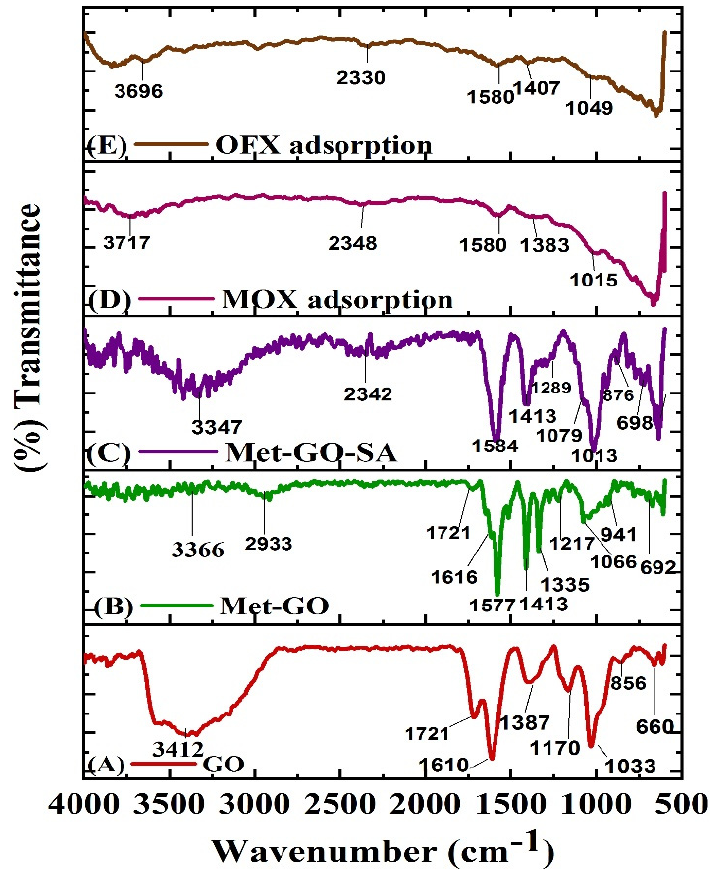
Figure 2. FTIR spectra of ( A ) GO, ( B ) Met-GO and ( C ) Met-GO/SA ( D ) after OFX adsorption ( E ) after MOX adsorption.